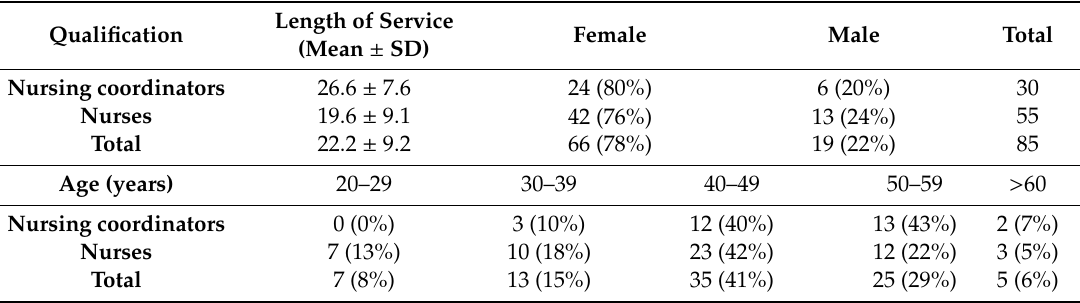
Table 1. Frequency distribution (values and row percentages), means and standard deviations of the sample’s characteristics.